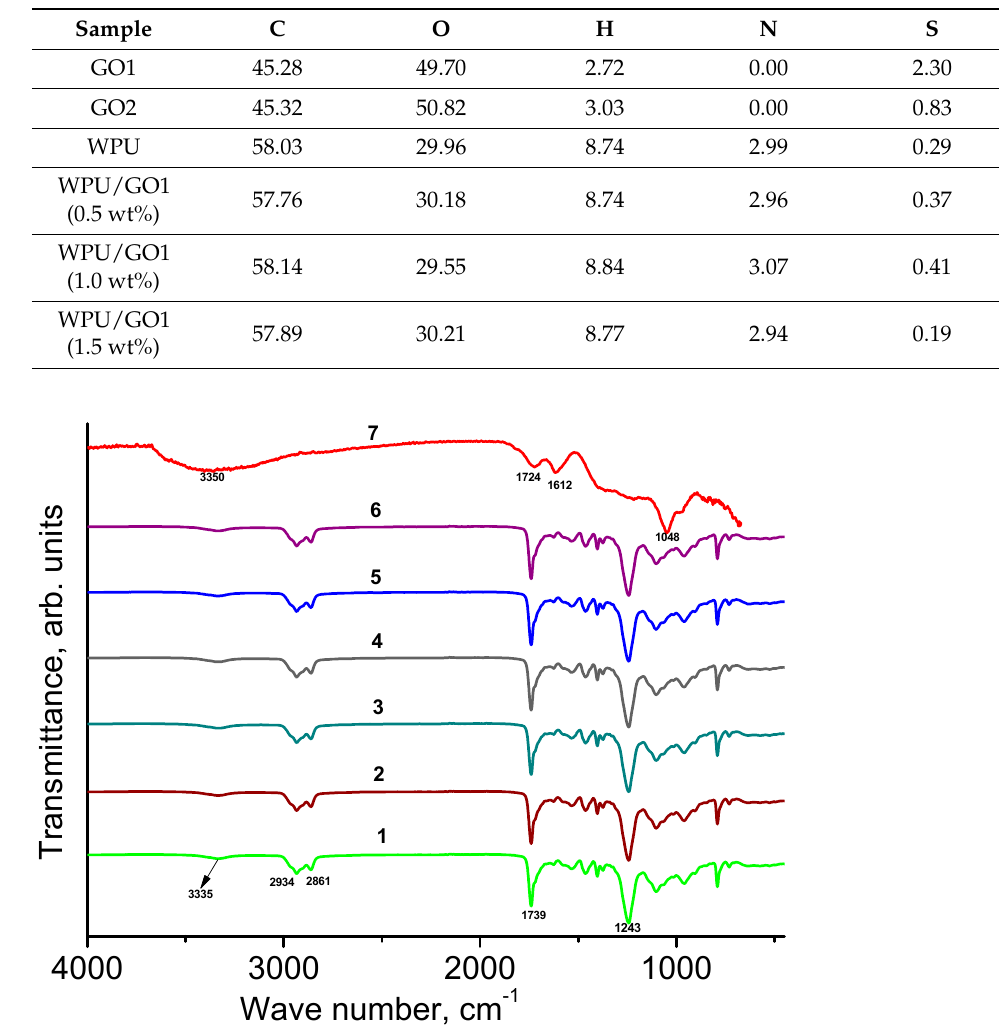
Table 1. Chemical composition (in wt%) of the graphene oxides, WPU, and some WPU/GO1 samples. (Oxygen content was estimated by the formula [O] = 100 − ∑ i [ C i ], where [ C i ] is the content of the i -th element.)